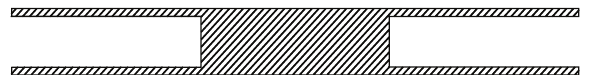
Figure 13: Conversion